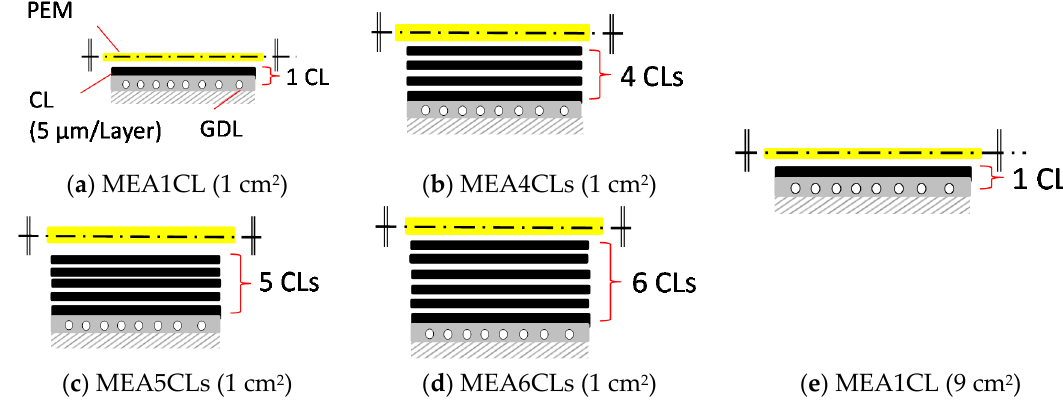
Figure 1. Printing image of catalyst ink on an MPL.